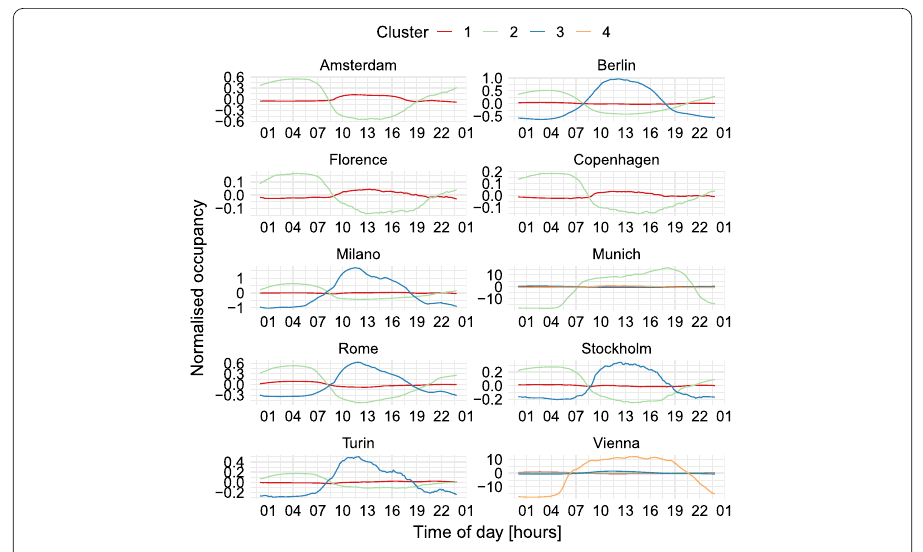
Figure 8 Time series of vehicle availability per cluster in the ten cities